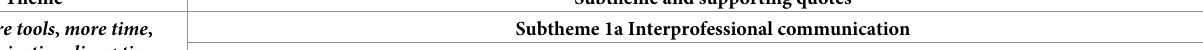
Table 1. Themes, subthemes and supporting